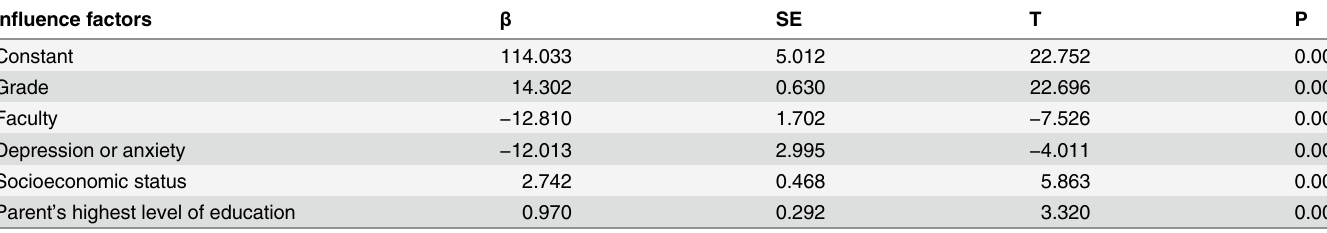
Table 3. Factors That Influence Health